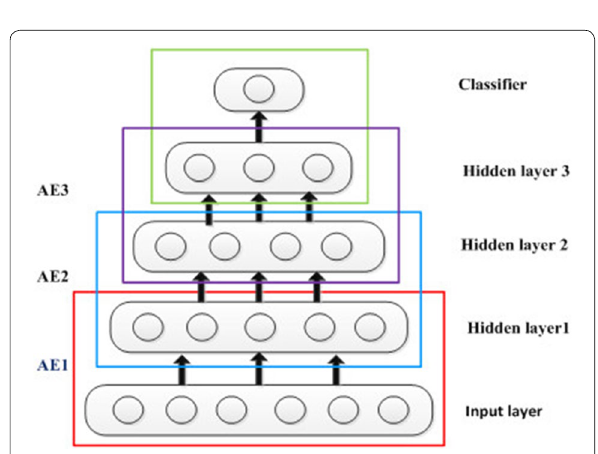
Figure 4 Architecture of stacked autoencoder